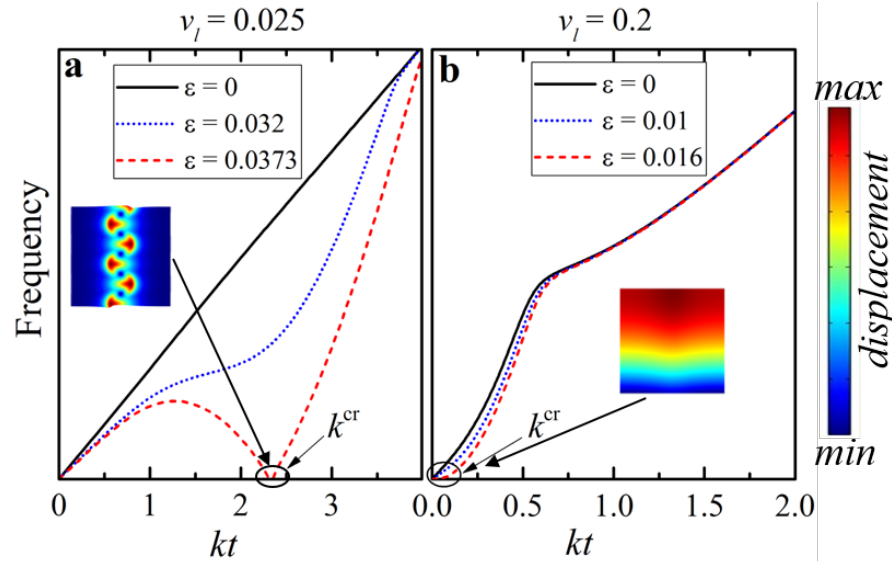
Figure 3. The evolution of the dispersion curves of the lowest eigenfrequency during compression of ideal layered composite with v l = 0.025 (dilute)—( a ) and v l = 0.2 (non-dilute)—( b ). The elastic modulus contrast is µ l / µ m = 100 .